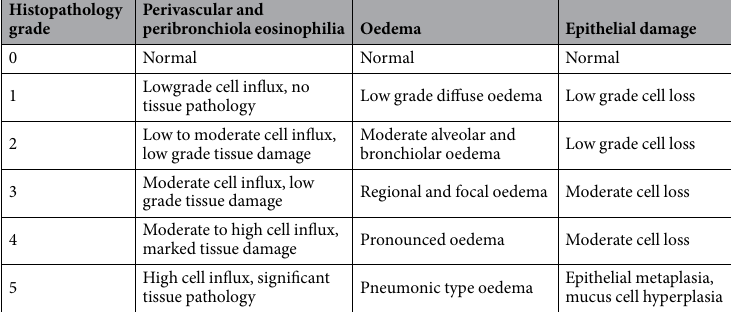
Table 2. Histopathological scoring system used to assess inflammatory change in lung.